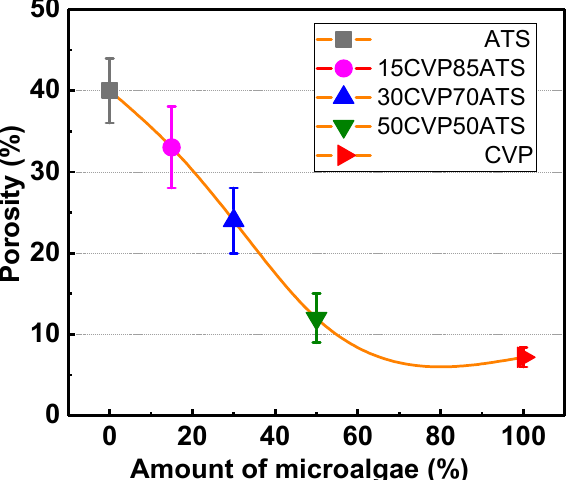
Figure 6. The relationship between porosity and microalgae addition.